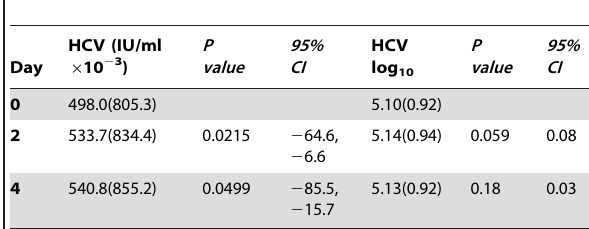
Table 7. Effects of Prednisone on serum HCV RNA titers.